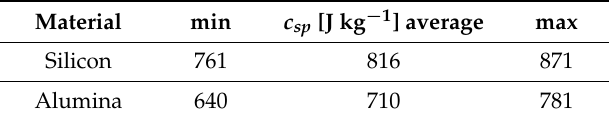
Table A3. Data calculated using Equation (A3) for silicon and alumina.